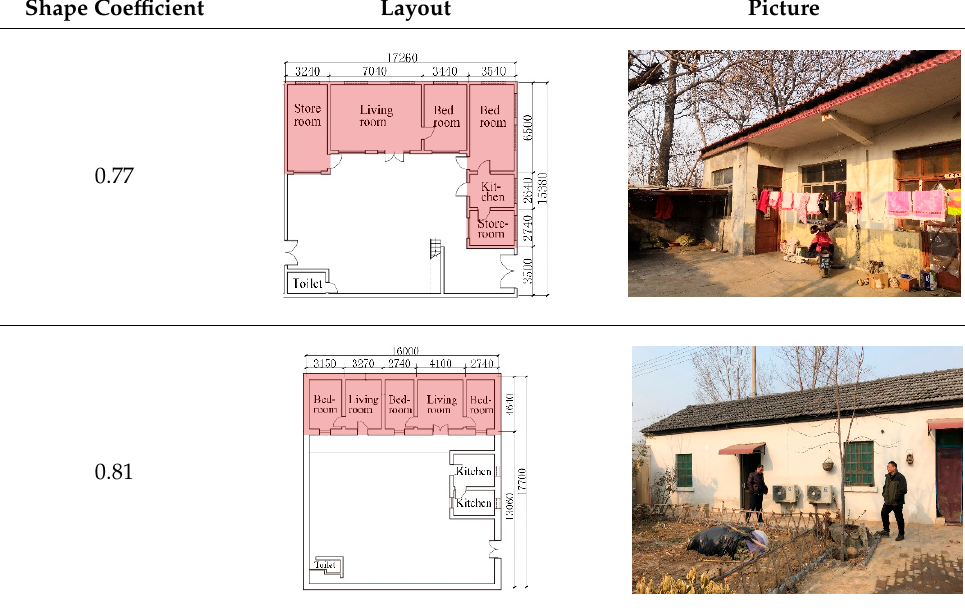
Table 1. The layout and shape coe ffi cient of rural houses in the research area. Table 1. The layout and shape coefficient of rural houses in the research area. Table 1. The layout and shape coefficient of rural houses in the research area. Table 1. The layout and shape coefficient of rural houses in the research area. Table 1. The layout and shape coefficient of rural houses in the research